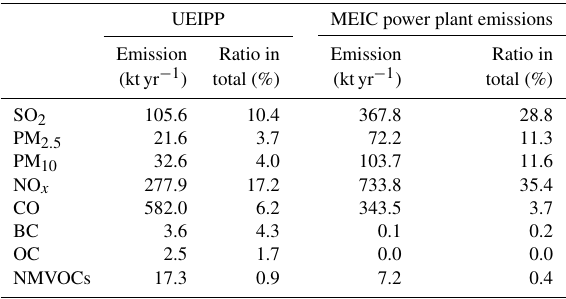
Table 1. The UEIPP and MEIC power plant emissions of major air pollutants as well as the ratios in total emission inventory over Jiangsu Province in